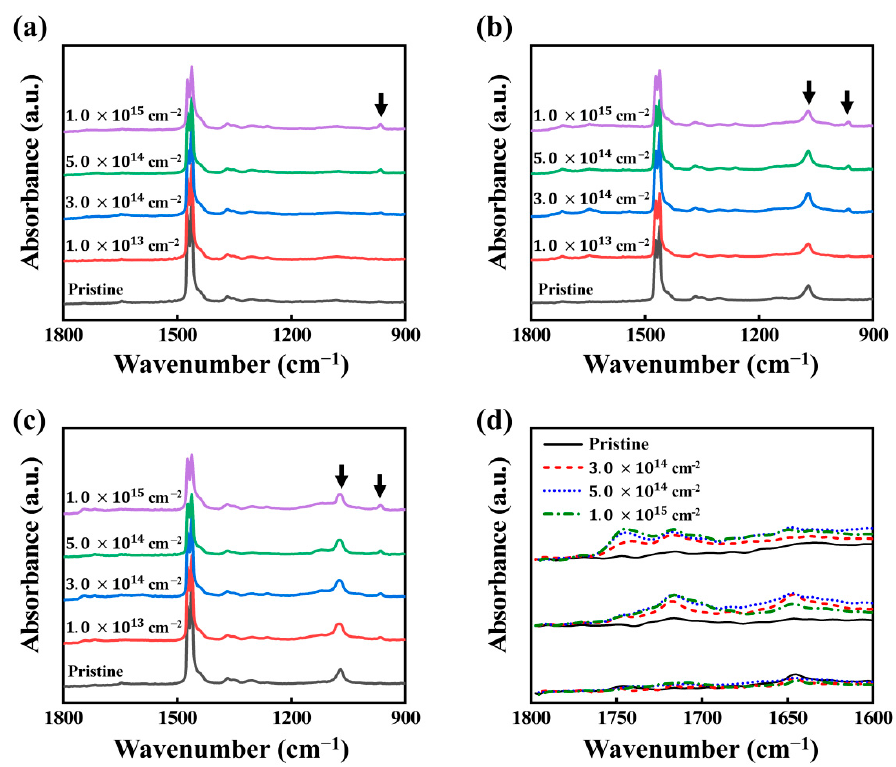
Figure 3. ATR–FTIR absorption spectra of ( a ) HDPE, ( b ) BA/HDPE, ( c ) vBA/HDPE before and after irradiation. ( d ) ATR–FTIR absorption spectra of irradiated HDPE, BA/HDPE, vBA/HDPE at the wavenumber range of 1800~1600 cm − 1 .